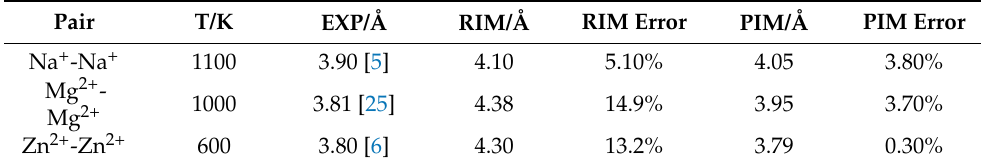
Table 5. First peak positions of cation–cation for molten chloride salts